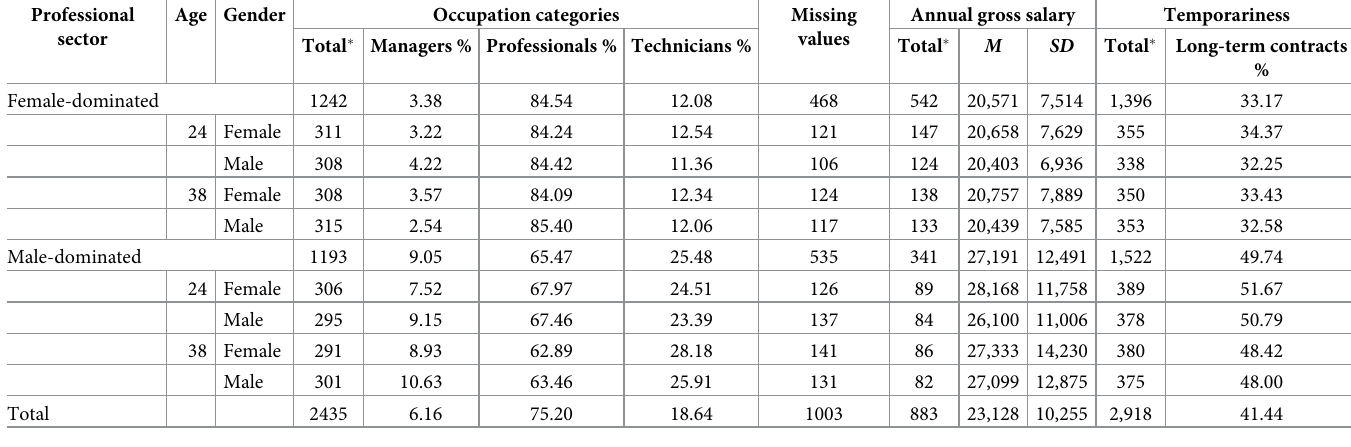
Note. � Total number of offers.